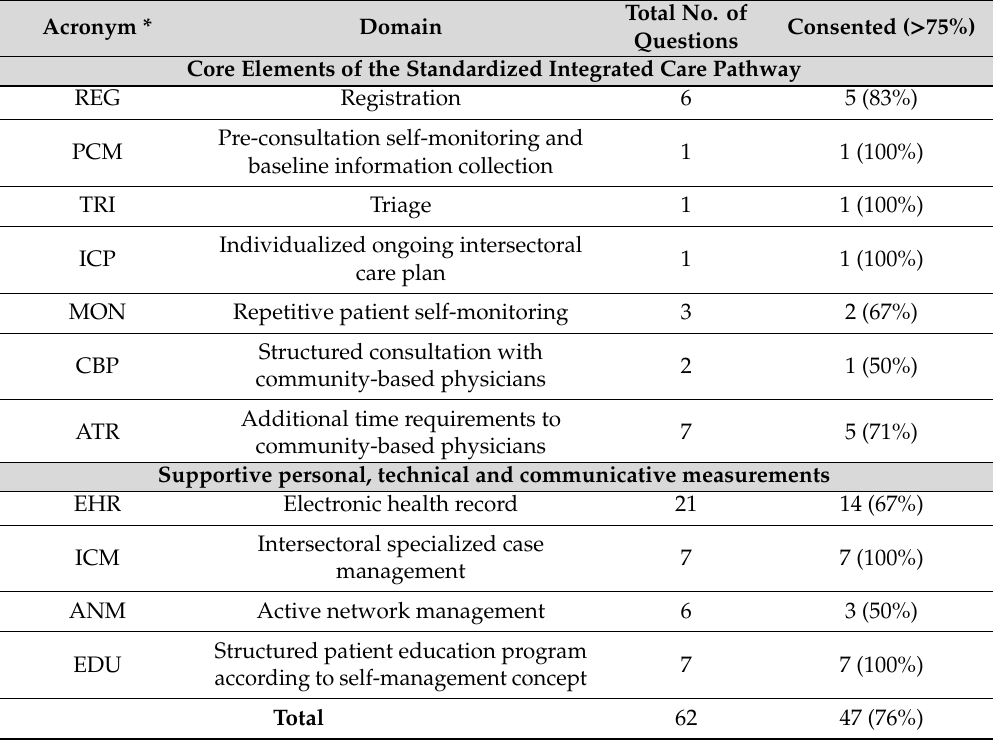
Table 2. Workshop contents allocated to their respective integrated care concept (ICC)